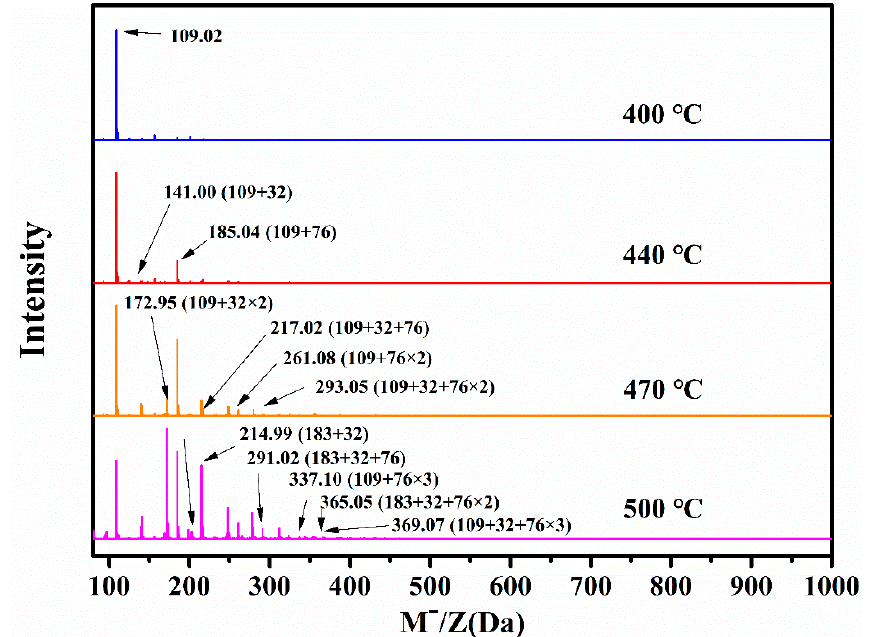
Figure 6. Q-TOF spectra of sodium thiophenolates at selected temperatures (APCI negative mode).